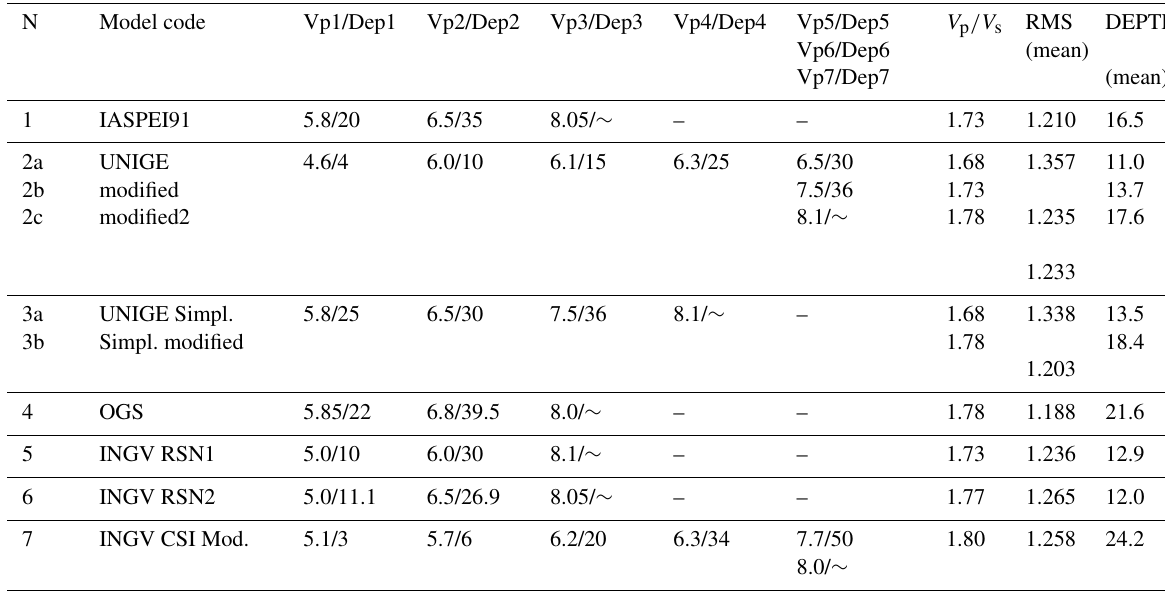
Table 2. Summary table of the velocity models tested in this study. The results in Figs. 8 and 9 are obtained with the model that minimizes time